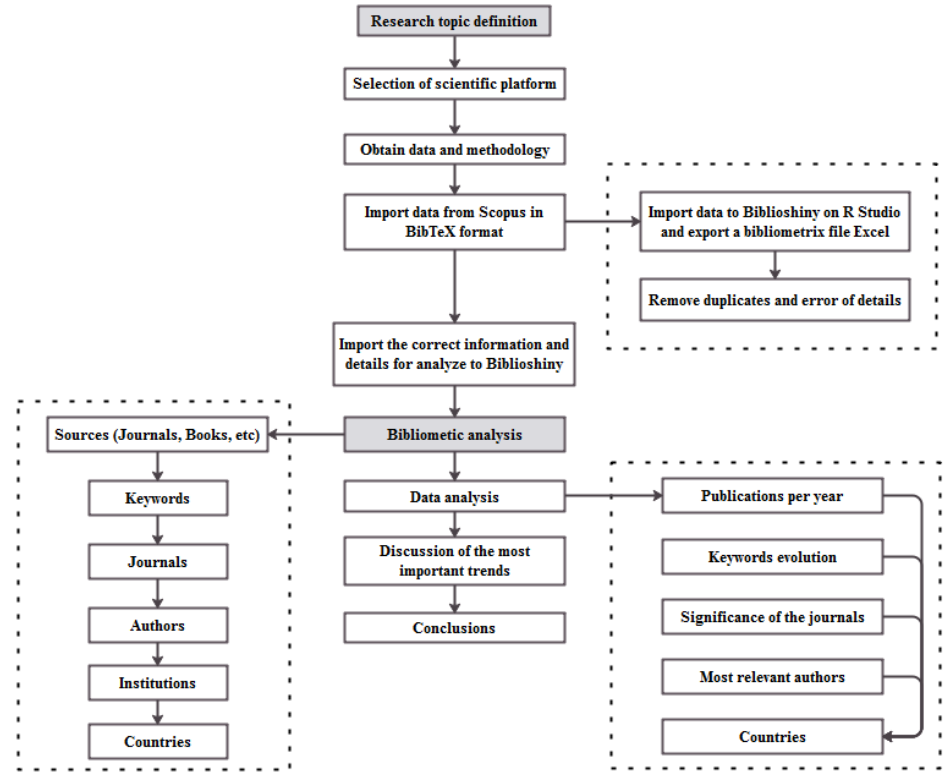
Figure 2. Workflow of the Bibliometric analysis obtained from García-León et al. [61–63].